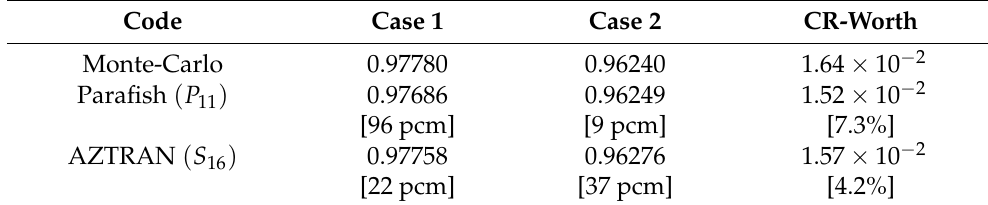
Table 1. Comparison of k ef f and control rod worth for small LWR